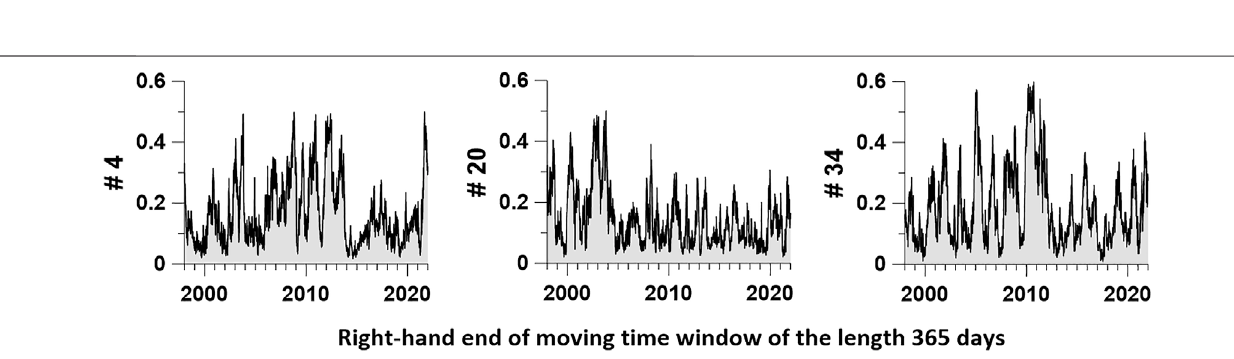
Frontiers in Earth Science |